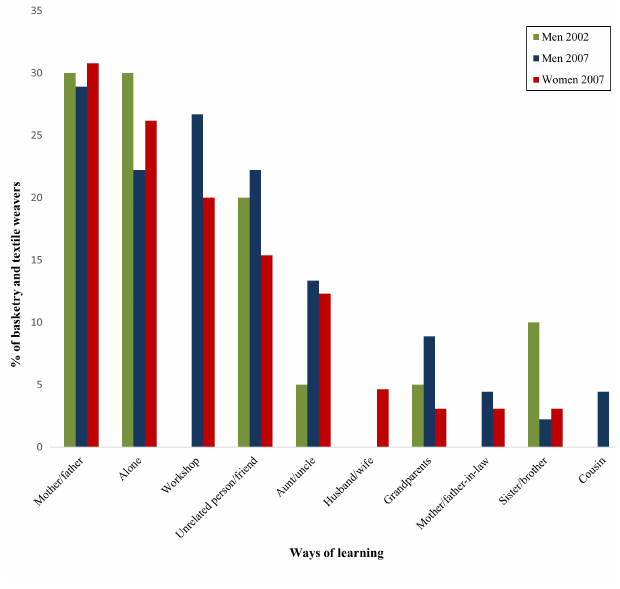
Fig. 5 . Comparison of ways of learning to weave baskets through a longitudinal assessment done before (2002) and after (2007) the Kaiabi Araa project, among men from Capivara and Tuiararé villages in Xingu. Learning from the workshop was an important category reported by men and women who participated in the indigenous-led weaving